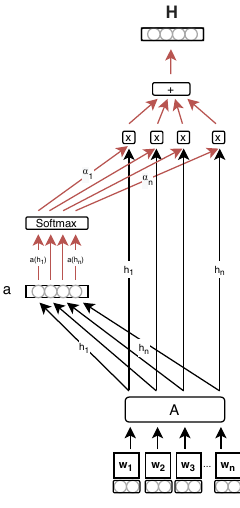
Figure 3. Attention mechanism. Table 1. Cas regression examples with attention weights visualized in shades of